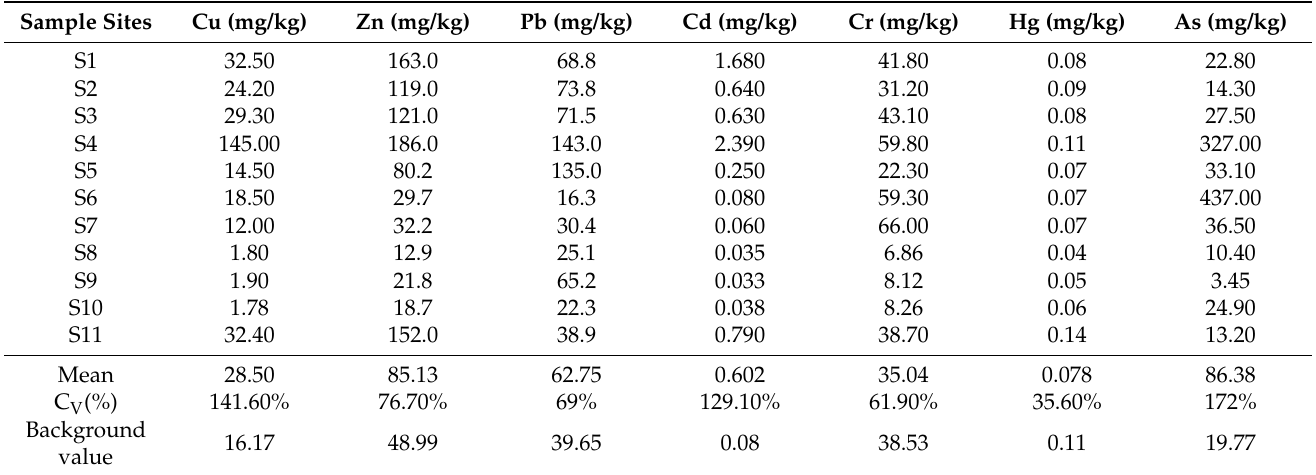
Table 1. Statistics of heavy metal concentration in sediments of XFJR.